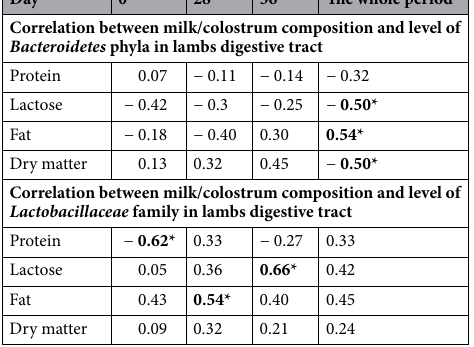
Table 5. Correlations between the microbiome of mothers milk/colostrum and lambs in the studied periods. * p <